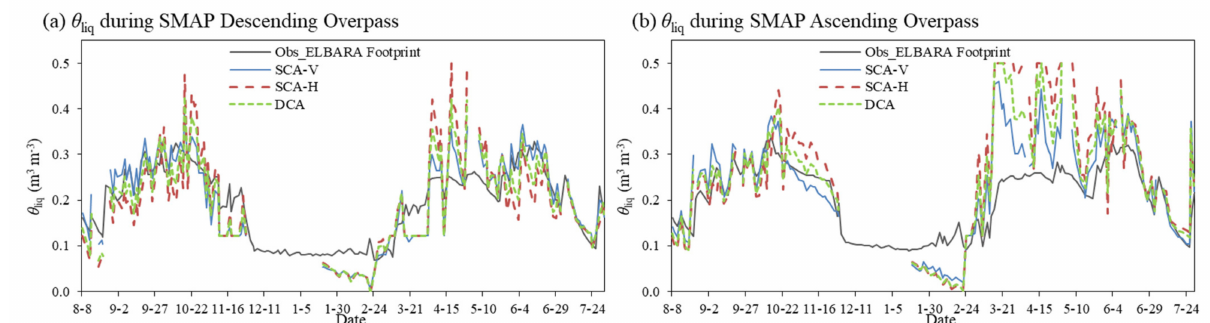
Figure 9. Time series of average θ liq measurements of ELBARA-III footprint and retrievals obtained by the SCA-V, SCA-H and DCA algorithms based on the ELBARA-III measured T B p measurements for the ( a ) descending and ( b ) ascending overpasses between August 2016 and July